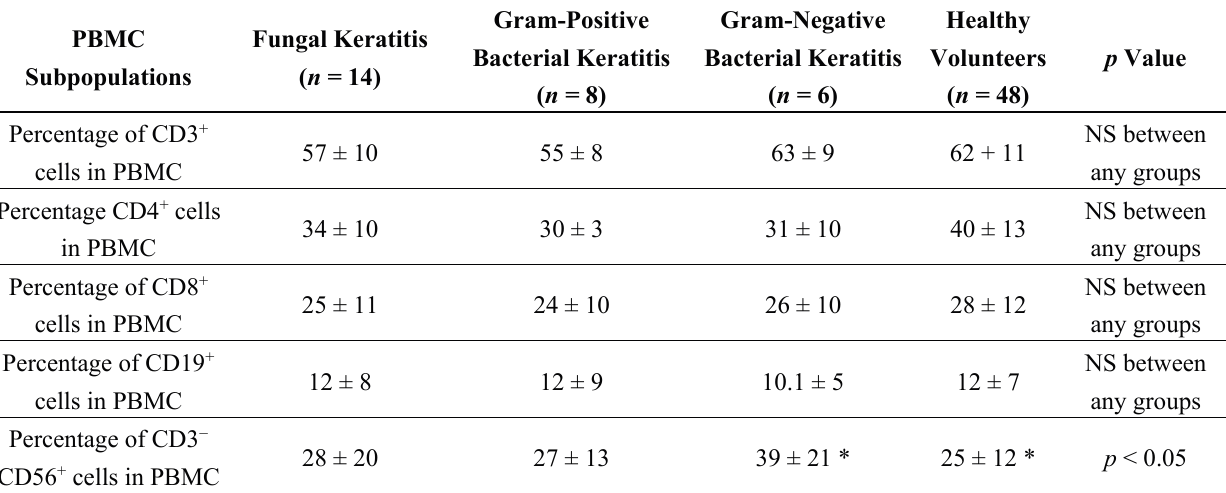
Figure 2. Frequency of CD3 − CD56 + cells in peripheral blood mononuclear cells (PBMC), PBMC were stained with fluorescent-conjugated antibodies to CD3 and CD56 in a double immunofluorescence assay, as described in the Material and Methods section. Lymphocytes were gated by their physical properties (forward and side scatter) to analyze the staining of cell-surface markers. Data are presented as dot plots from gated lymphocytes. Representative images were taken from one patient of each group, and one of 48 healthy volunteers. Table 3. Frequency of PBMC sub-populations in patients with microbial